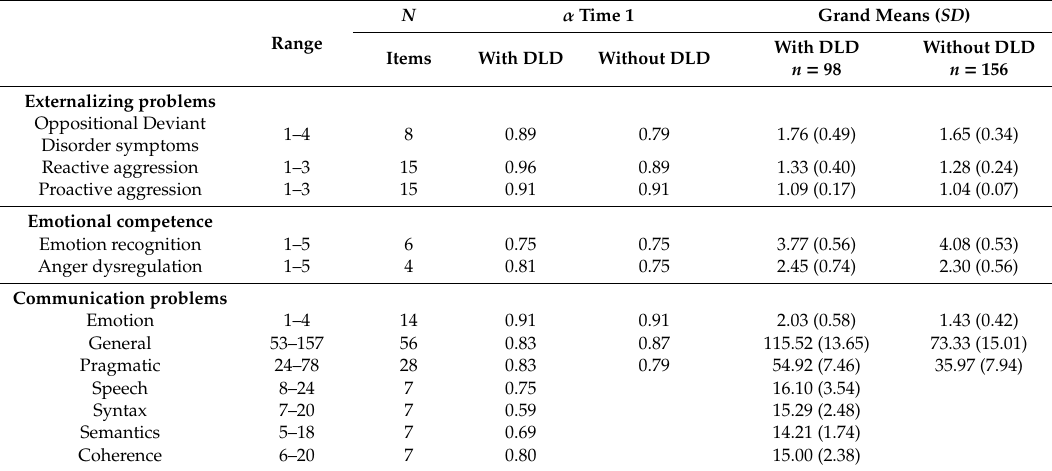
Table 2. Psychometric properties of the questionnaires for children with and without Developmental Language Disorder (DLD). N α Time 1 Grand Means ( SD ) Range Items With DLD Without DLD